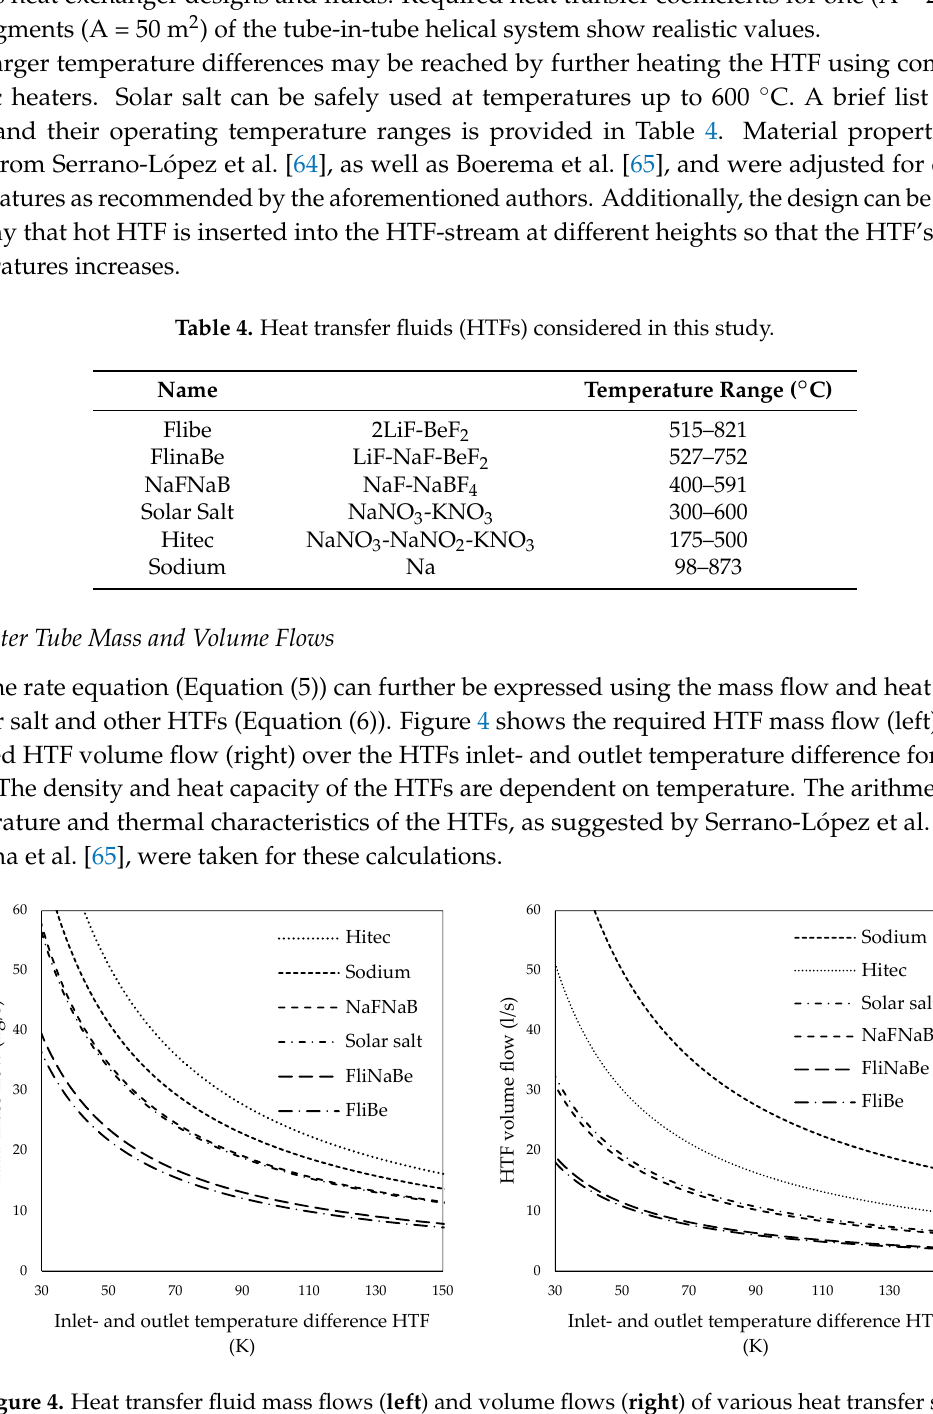
Figure 4. Heat transfer fluid mass flows ( left ) and volume flows ( right ) of various heat transfer salts over the inlet- and outlet temperature difference of the outer tube.